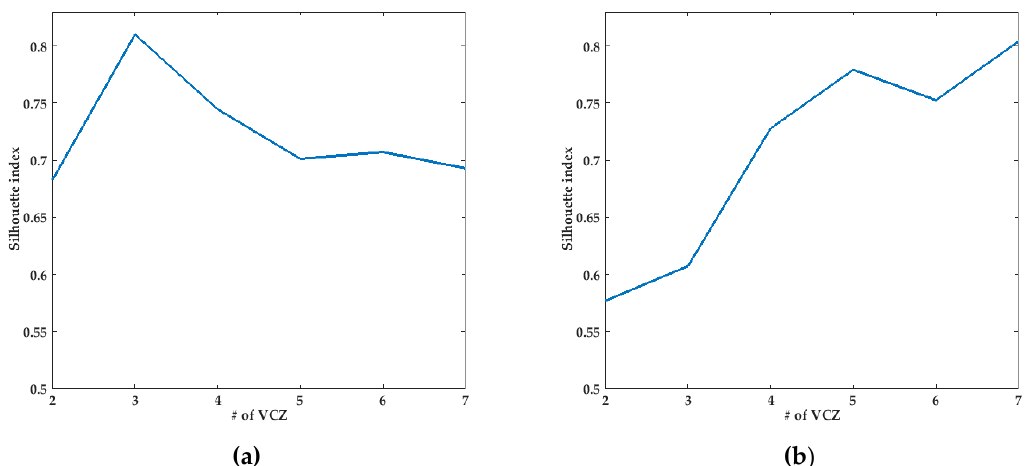
Figure 3. The Silhouette index for the three different cases: ( a ) P algorithm, ( b ) Q algorithm.